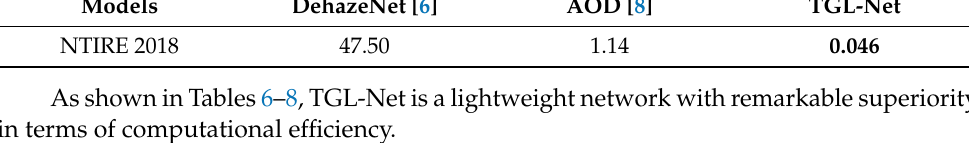
Table 8. Average run time (in seconds) on the NTIRE 2018 dataset. Models